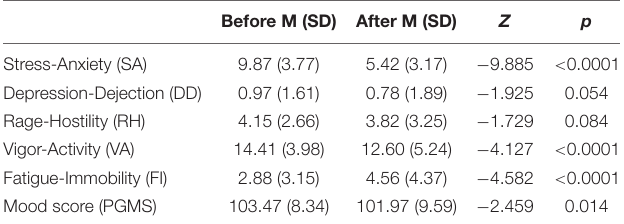
TABLE 1 | Scores obtained on the POMS scales before and after the choreography, in the 1st phase. Before M (SD) After M (SD)